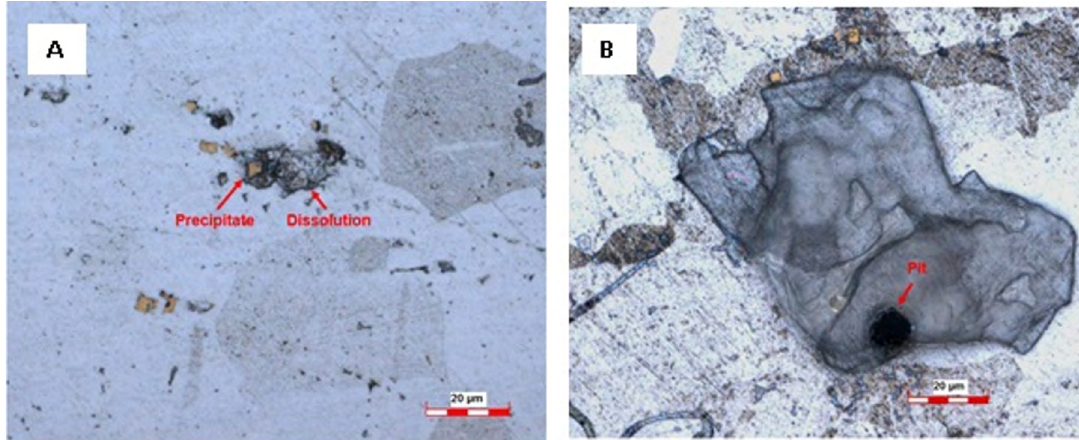
Figure 12. CLSM images of the AISI 409 stainless steel after potentiodynamic polarization in 0.1 M NaCl solution at room temperature: a) Dissolution around a gold-colored precipitate; b) pit formed in the boundary of a grey-colored precipitate.